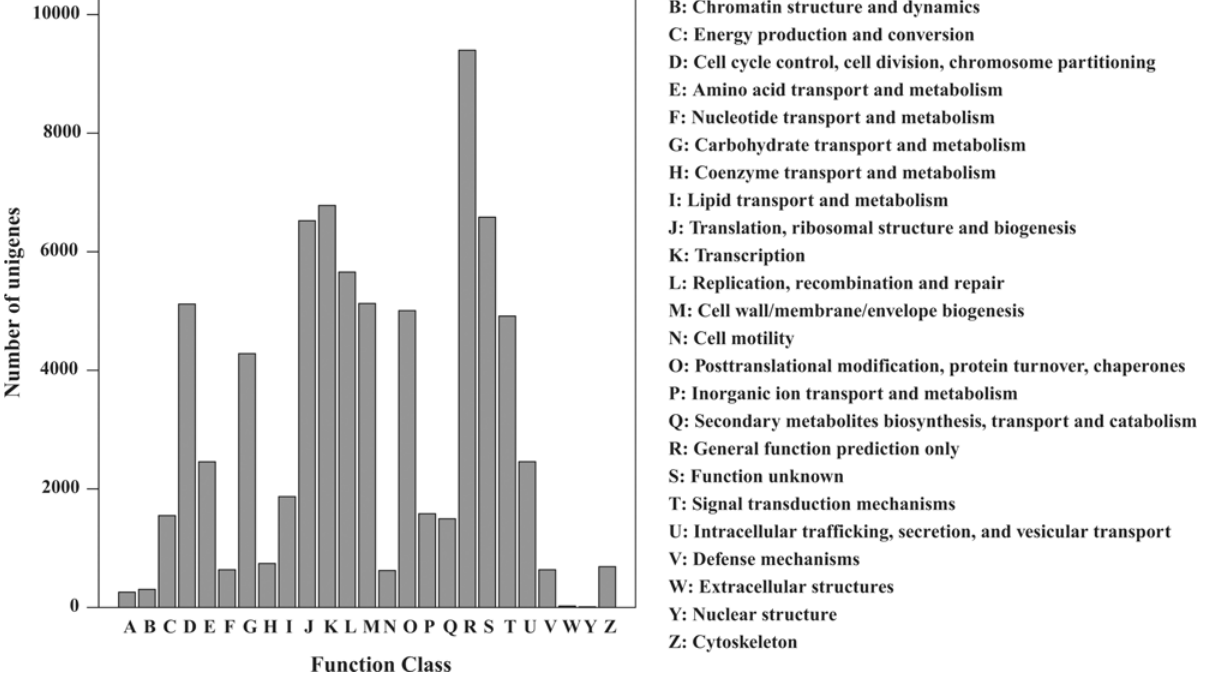
Fig 4. Histogram of the COG (clusters of orthologous groups) functional classification of all of the S . grandis unigenes. Out of the 94,674 de novo assembled unigenes, 26,156 were annotated and grouped into 25 categories.